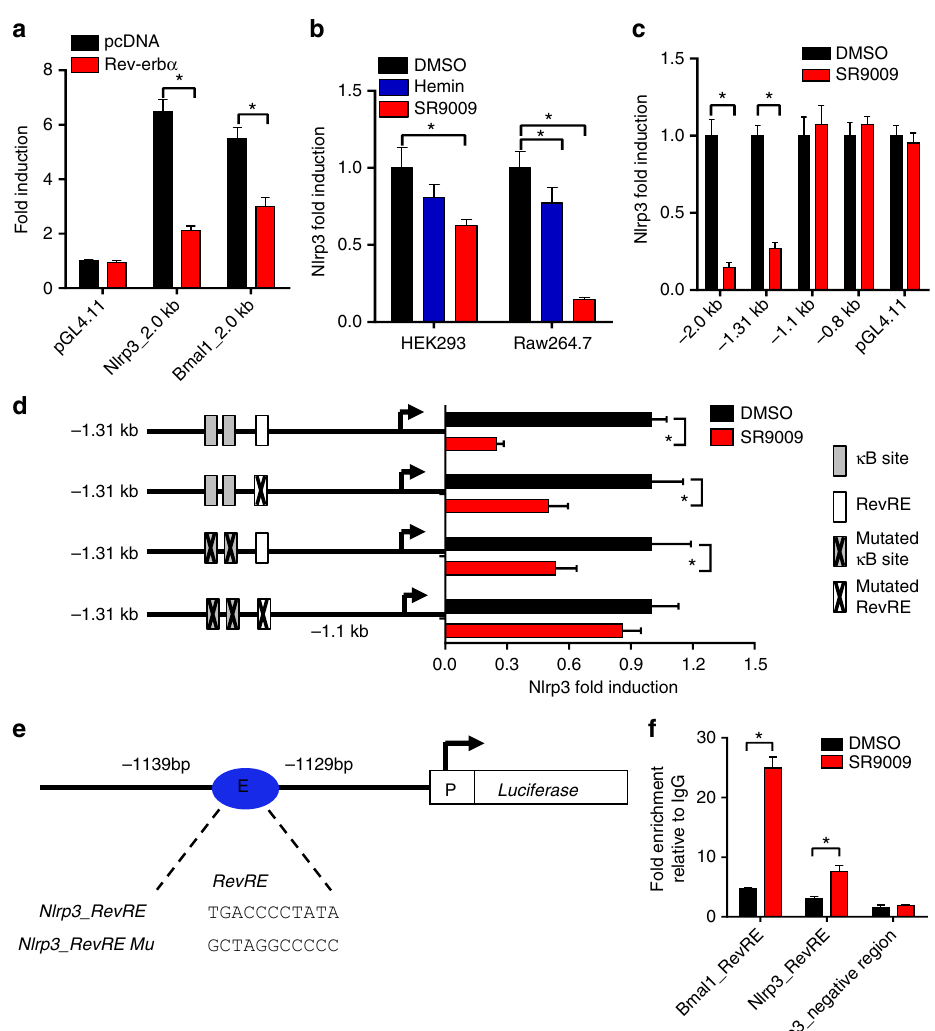
Fig. 5 Rev-erb α binds to Nlrp3 promoter and inhibits Nlrp3 transcription. a Luciferase reporter assays showing that Rev-erb α represses Nlrp3 transcription in Raw264.7 cells. The cells were transfected with blank PGL4.11, 2.0 kb Nlrp3 reporter, or 2.0 kb Bmal1 reporter along with blank pcDNA or Nr1d1 plasmid. Data are mean ± SD ( n = 4). b Luciferase reporter assays showing that Rev-erb α activation downregulates Nlrp3 transcription in HEK293 and Raw264.7 cells. HEK293 cells were transfected with the 2.0 kb Nlrp3 reporter followed by treatment with SR9009 (or vehicle) for 12 h. Raw264.7 cells were transfected with the 2.0 kb Nlrp3 reporter followed by treatment with SR9009 (or vehicle) for 1 h and LPS for 8 h. Data are mean ± SD ( n = 6). c Luciferase reporter assays with distinct Nlrp3 reporters in Raw264.7 cells. Raw264.7 cells were transfected with blank PGL4.11 and Nlrp3 reporter (i.e.,